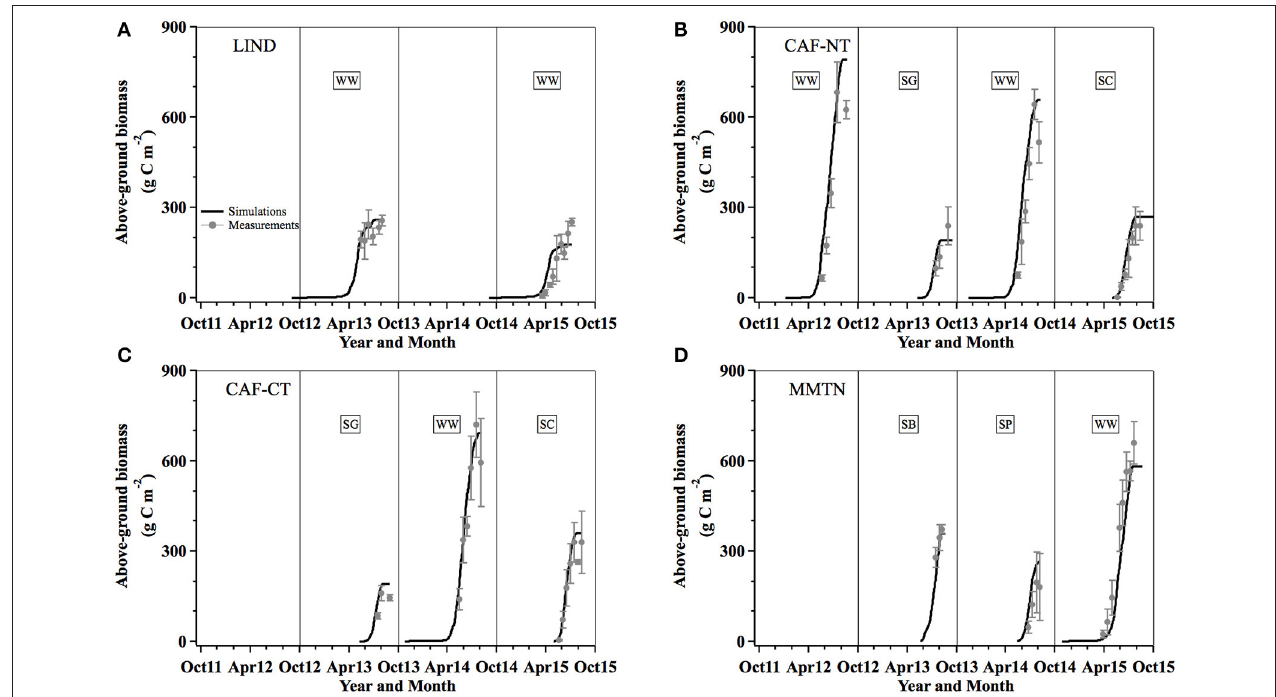
FIGURE 2 | CropSyst modeled and field measured above-ground biomass carbon content at LIND (A) , CAF-NT (B) , CAF-CT (C) , and MMTN (D) . WW, winter wheat; SG, spring garbanzo; SC, spring canola; SB, spring barley; SP, spring